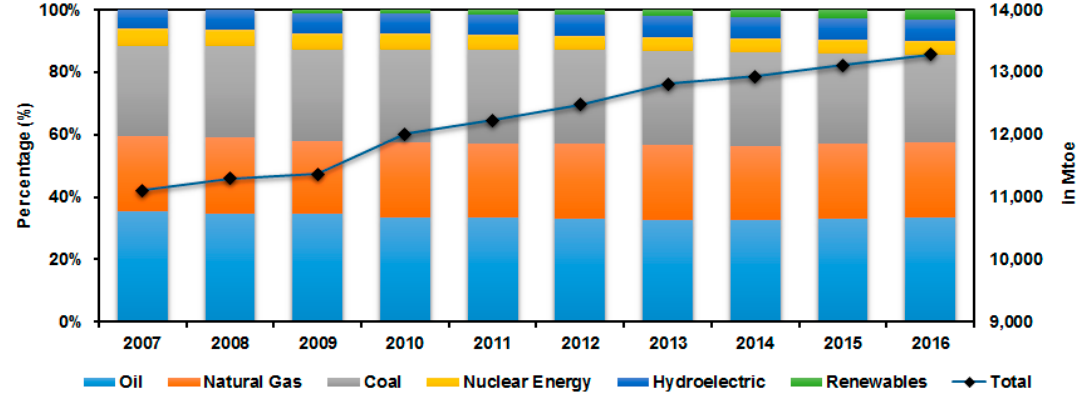
Figure 1. Total primary energy consumption (2007–2016). Adapted from [29–33].